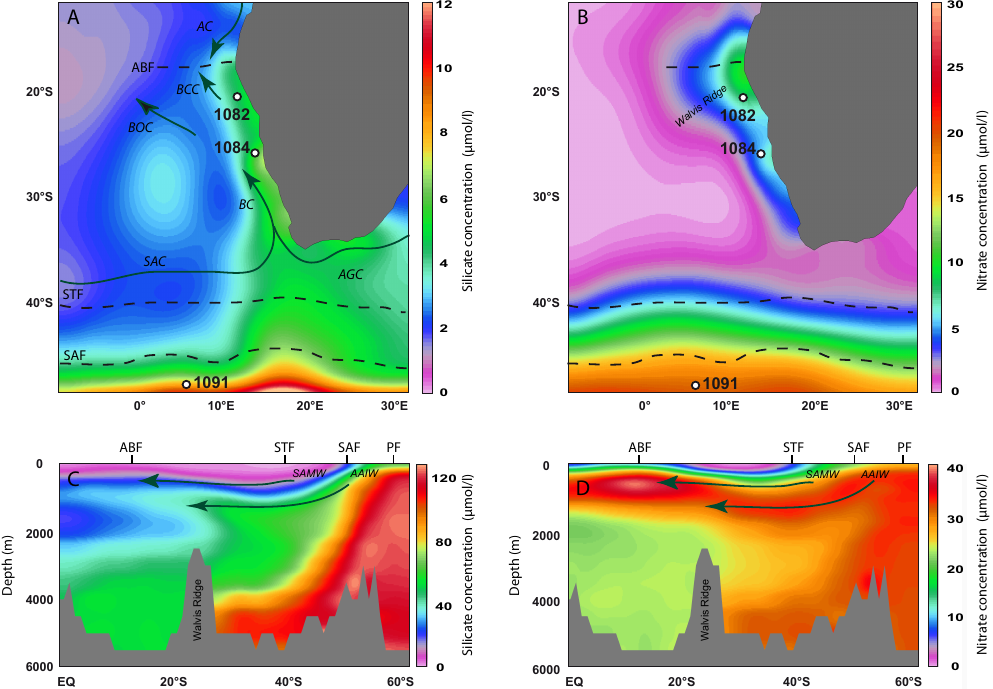
Fig. 1. Silicate and nitrate concentrations (µmoll − 1 ) at 10m water depth ( A , B ) and of water masses along a latitudinal transect ( C , D ). White dots indicate the location of the Benguela ODP Sites 1082 and 1084 as well as the South Atlantic Site 1091. As illustrated here, Si is supplied in the BUS by the upwelling of SAMW, subantarctic mode waters, and AAIW, Antarctic Intermediate Waters, formed in the Southern Ocean, in the polar frontal system zone. AC, Angola Current; AGC, Aghulas Current; BC, Benguela Current; BCC, Benguela Coastal Current; BOC, Benguela Oceanic Current; SAC, South Atlantic Current; STF, Subtropical Front; SAF, Subantarctic